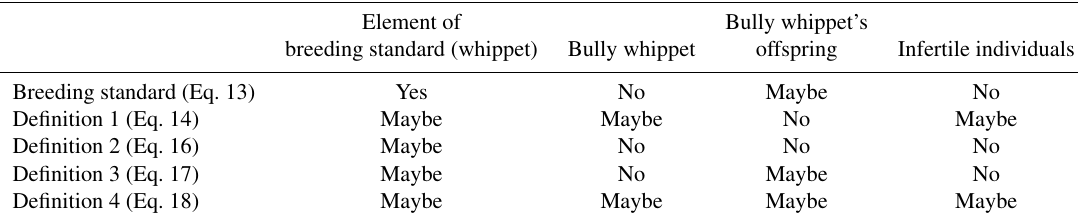
Table 2. This table provides a summary of the elements that are part of the breed sets according to the different breed definitions, if they are applied to the dog breed “whippet”. A “No” within the table means that the object is not part of the corresponding set (e.g., a bully whippet is definitely not part of the whippet’s breeding standard). A “Yes” within the table means that the object is definitely part of the corresponding set (e.g., dogs that fulfill the breeding standard are part of the breeding standard set). A “Maybe” means that the object may be part of the corresponding set if certain conditions are fulfilled (e.g., in definition 3: dogs that fulfill the breeding standard are only an element of the breeding standard set if another dog exists that fulfills the breeding standard, and the probability for common offspring being an element of the breeding standard exceeds